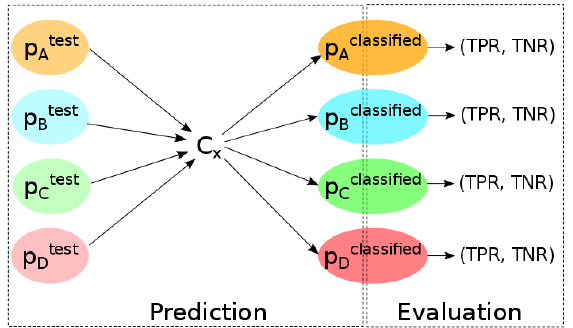
Figure 8. Observing the performance of each classifier by predicting vandalism in each study